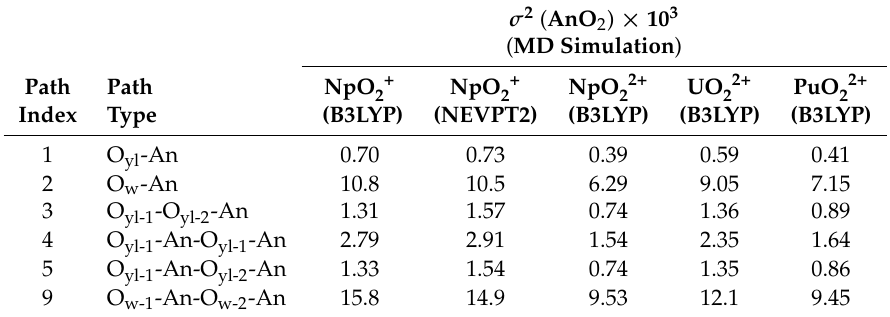
(H O) ] +/2+ in water derived from MD 2 2 5 2